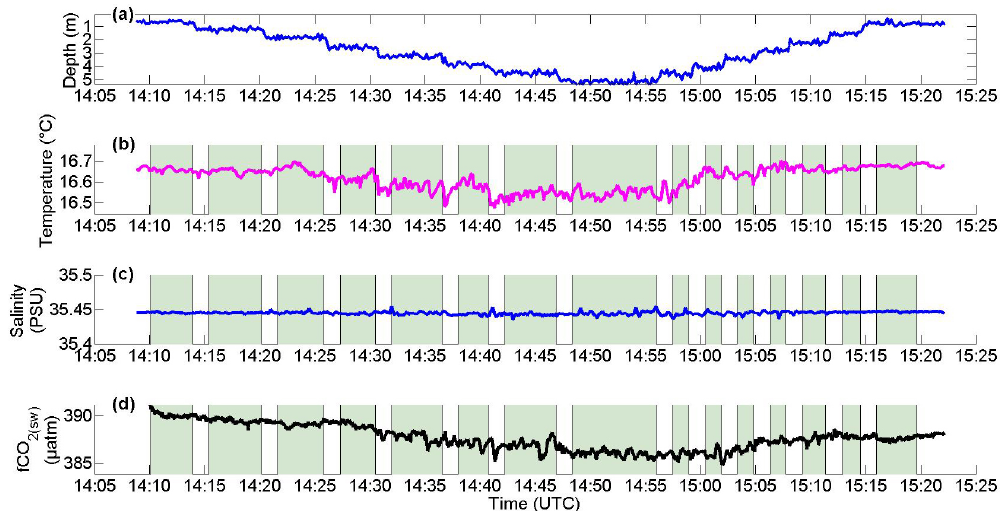
Figure 5. Time series measurements made during an NSOP deployment in the Celtic Sea on 30 July 2015. Data are 1Hz depth (a) , seawater temperature (b) , salinity (c) and f CO 2 ( sw ) (d) . Data used for depth bin analysis (Sect. 2.6) are identified by a shaded